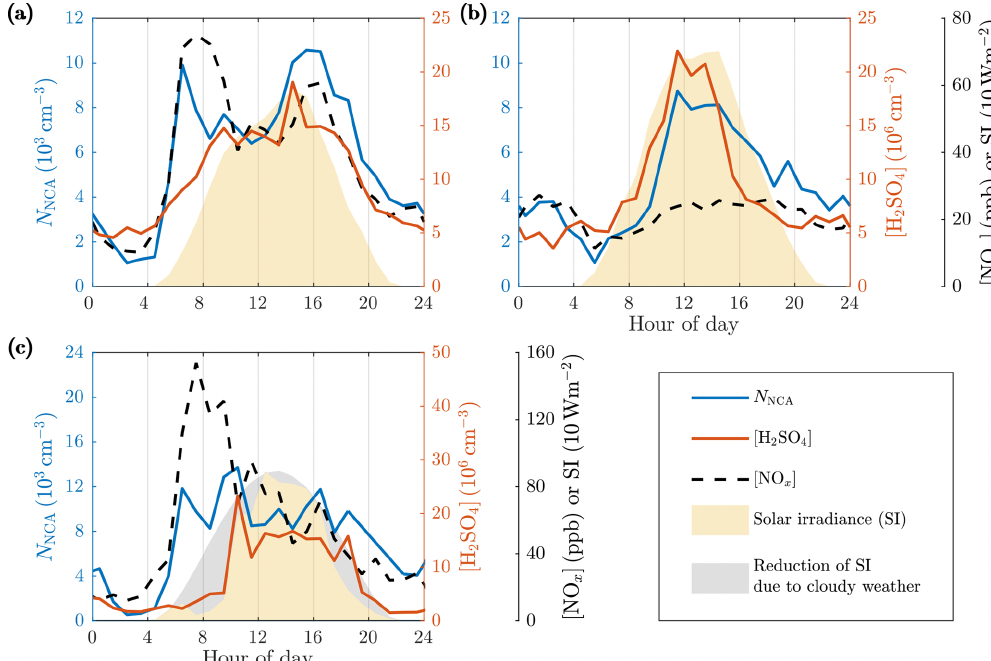
Figure 5. Average diurnal variations in the NCA, H 2 SO 4 , and NO x concentrations and solar irradiance (SI) on (a) weekdays, (b) weekends, and (c) example day 22 May 2017 with a cloudy morning and evening. The concentration data first averaged to 1h time resolution are averaged geometrically as described in Fig.